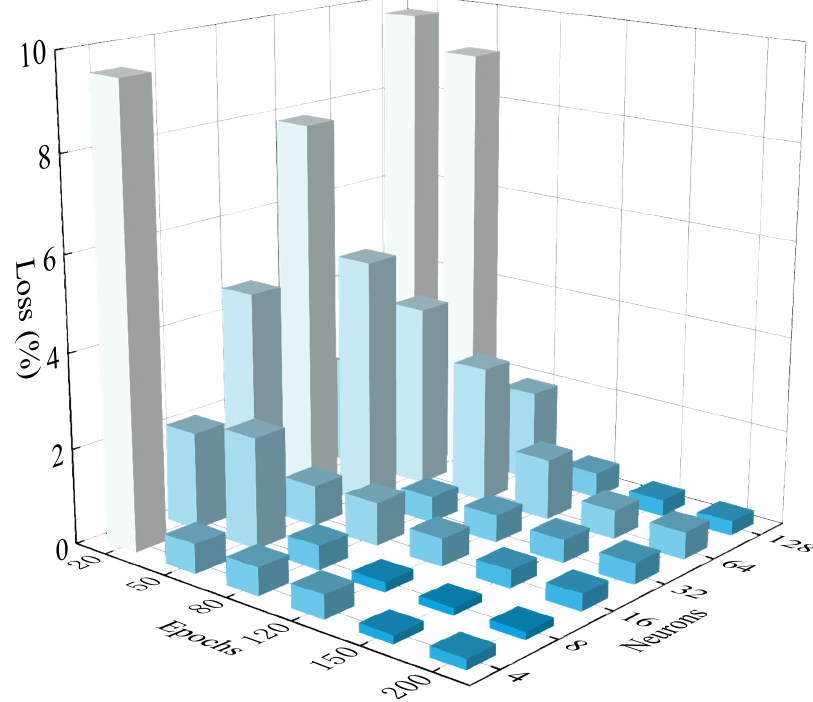
Figure 5. MAE under different hyperparameters: neurons and epoch.